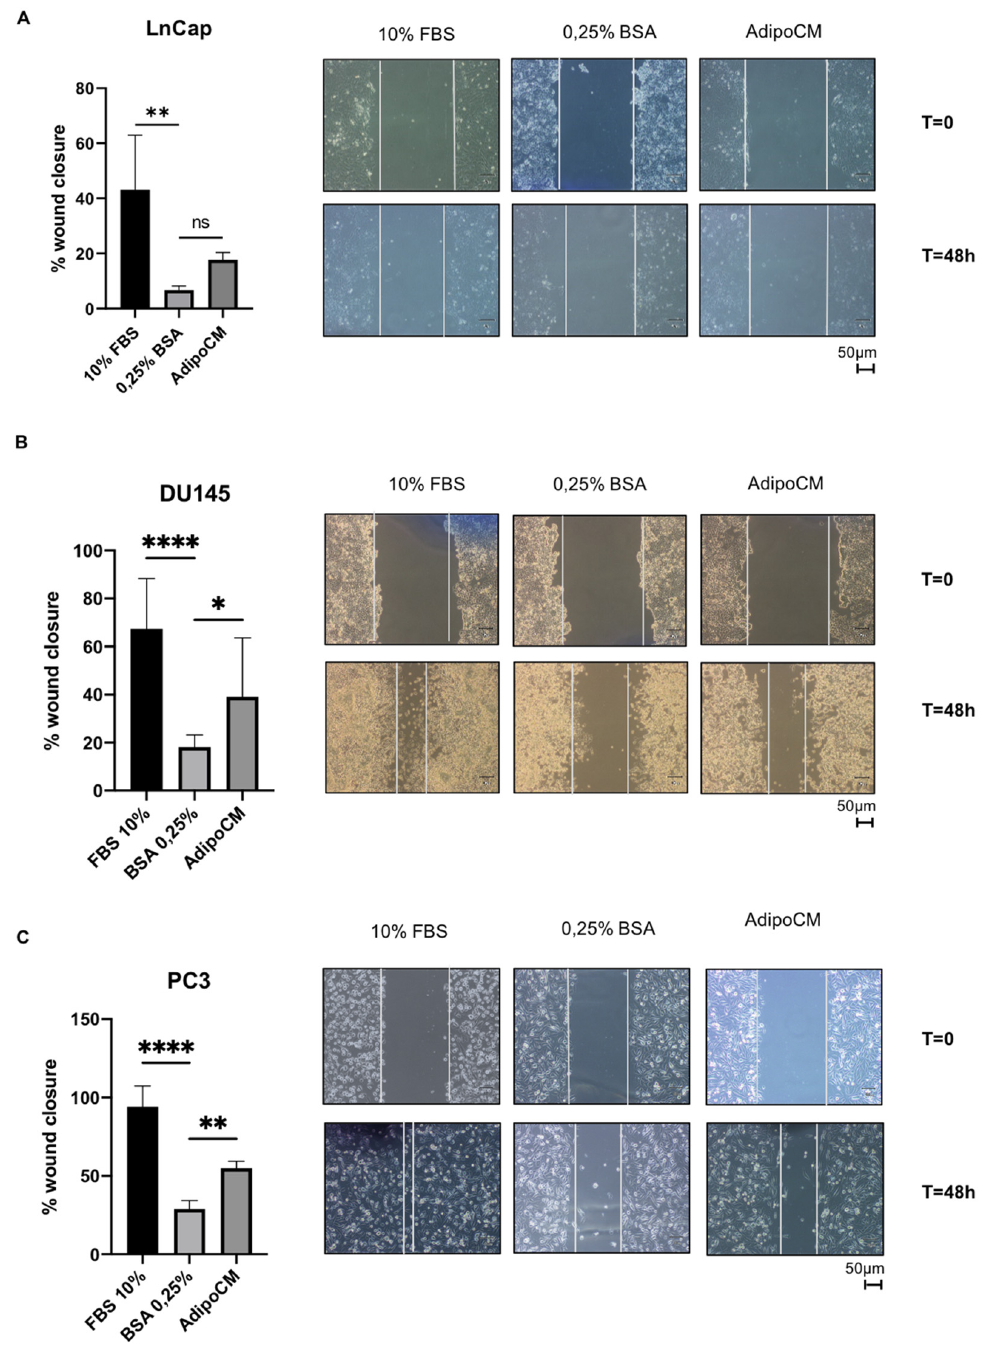
Figure 1. Adipocyte-conditioned media-induced PCa cell lines migration. LnCaP ( A ), DU145; ( B ) and PC3; ( C ) cells were seeded (5 × 10 5 cells/well) in 12-well plates and allowed to form a confluent cell monolayer. Cell layers were wounded with a micropipette tip and then incubated with medium containing 10% FBS, 0.25% BSA or conditioned medium obtained from adipocytes. The images were acquired at 0 and 48 h using a camera connected to the microscope. Cell migration toward the wounded area was observed, photographed and measured (magnification 10×). Graphs show the percentage of wound healing rate. * Indicates a p -value < 0.05, ** indicates a p -value < 0.01 and **** a p -value ≤ 0.0001.